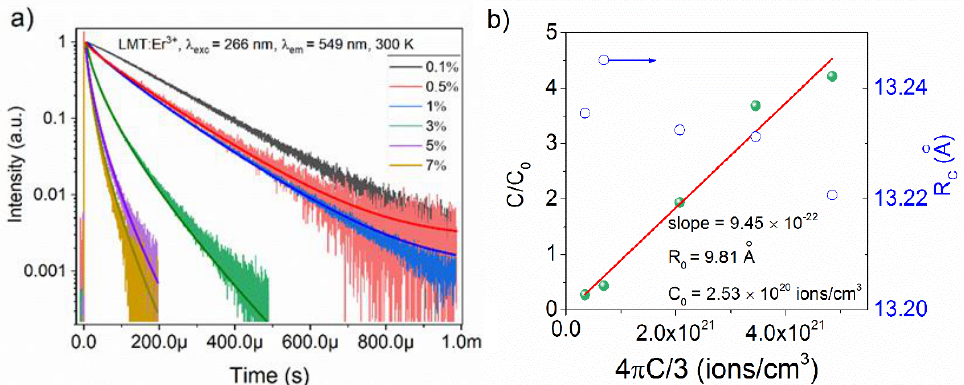
Figure 7. ( a ) The 300 K decay profiles under 266 nm excitation, monitored at 549 nm and fitted to the Inokuti–Hirayama function (solid lines) for S = 6; ( b ) critical transfer distance R 0 and critical concentration C 0 calculated from the slope of the plot of ( C/C 0 ) vs. ( 4 π C/3 ) and the interionic distance between dopants (R c ) of all Er 3+ -doped samples (right Y